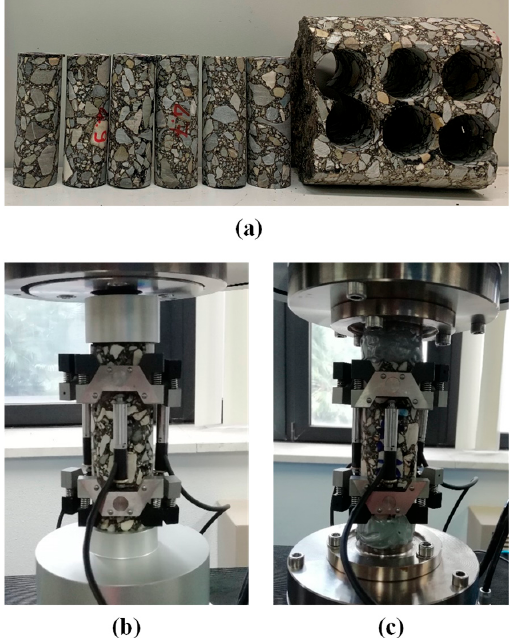
Figure 3. Experimental investigation: ( a ) testing specimens horizontally cored from the base course, ( b ) setup of the dynamic modulus tests, ( c ) setup of the cyclic fatigue tests.